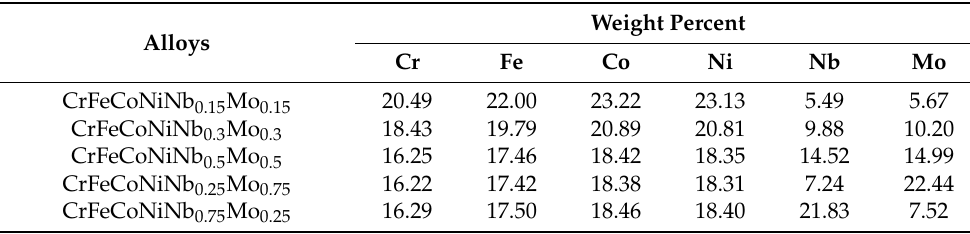
Table 1. The nominal compositions of the as-cast alloys.